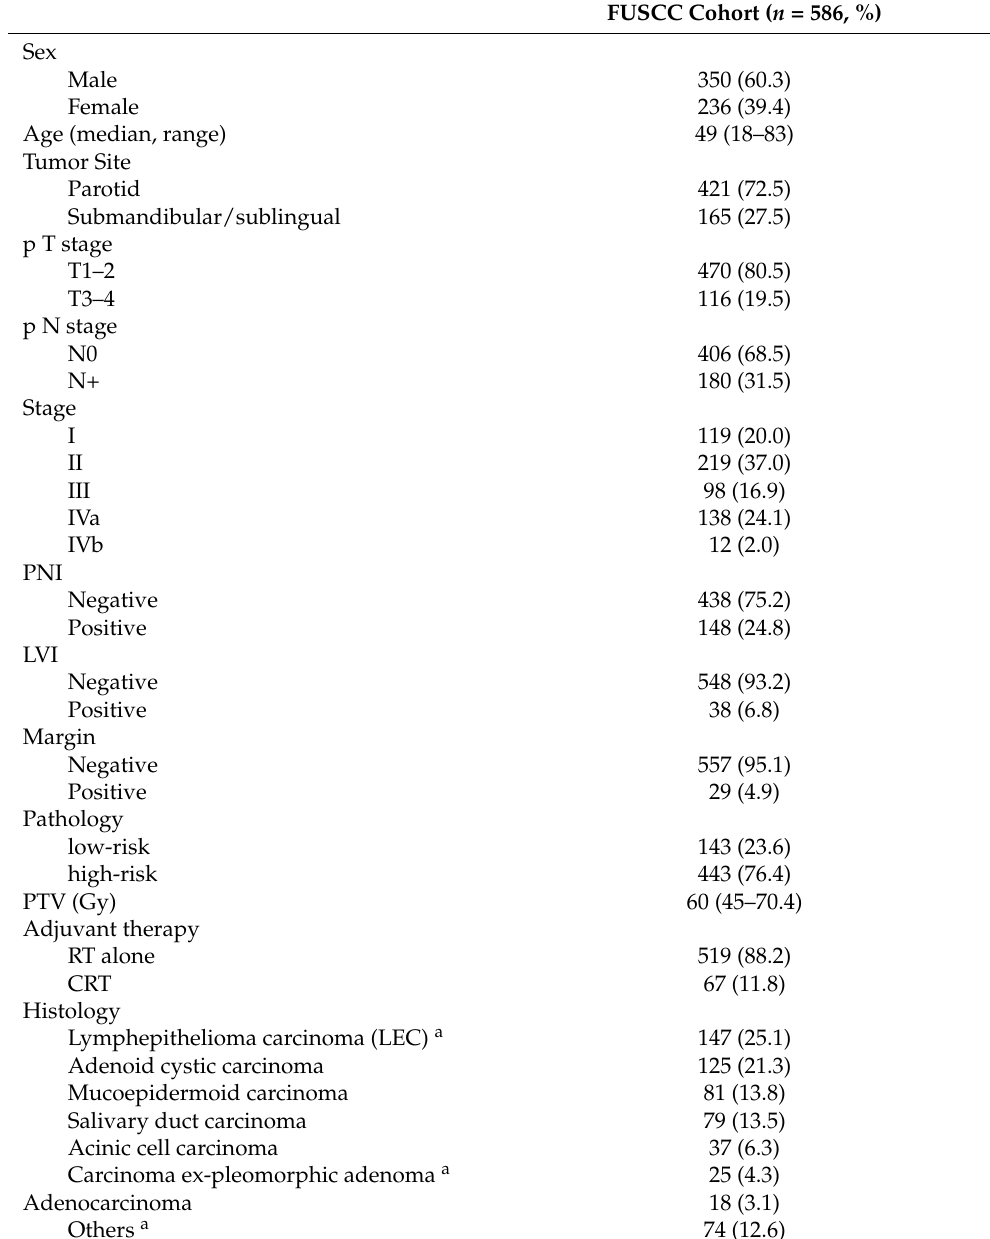
Table 1. The clinicopathological features of the patients in the external